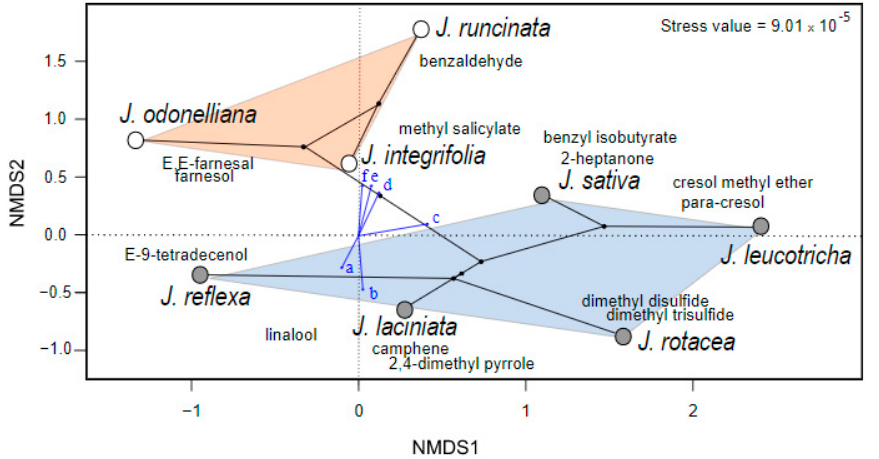
Figure 3. Phylo-scent space of studied Jaborosa species. Non-metric multidimensional scaling (NMDS) of the floral scent profiles (Supplementary Table S3). Phylogenetic relationships among Jaborosa species were projected into the space (white and grey circles show species from the Subtropical Lowland and Andean clades, respectively). Some VOCs that are important explaining differences between floral scent samples are shown. Blue arrows show the influence of environmental variables in scent space (a: temperature seasonality, b: altitude, c: mean diurnal range temperature, d: maximum temperature of the warmest month, e: specific humidity of the most humid month, and f: mean temperature of the least humid quarter). According to a PERMANOVA analysis, the scents differed between species of the Subtropical and the Andean clades.